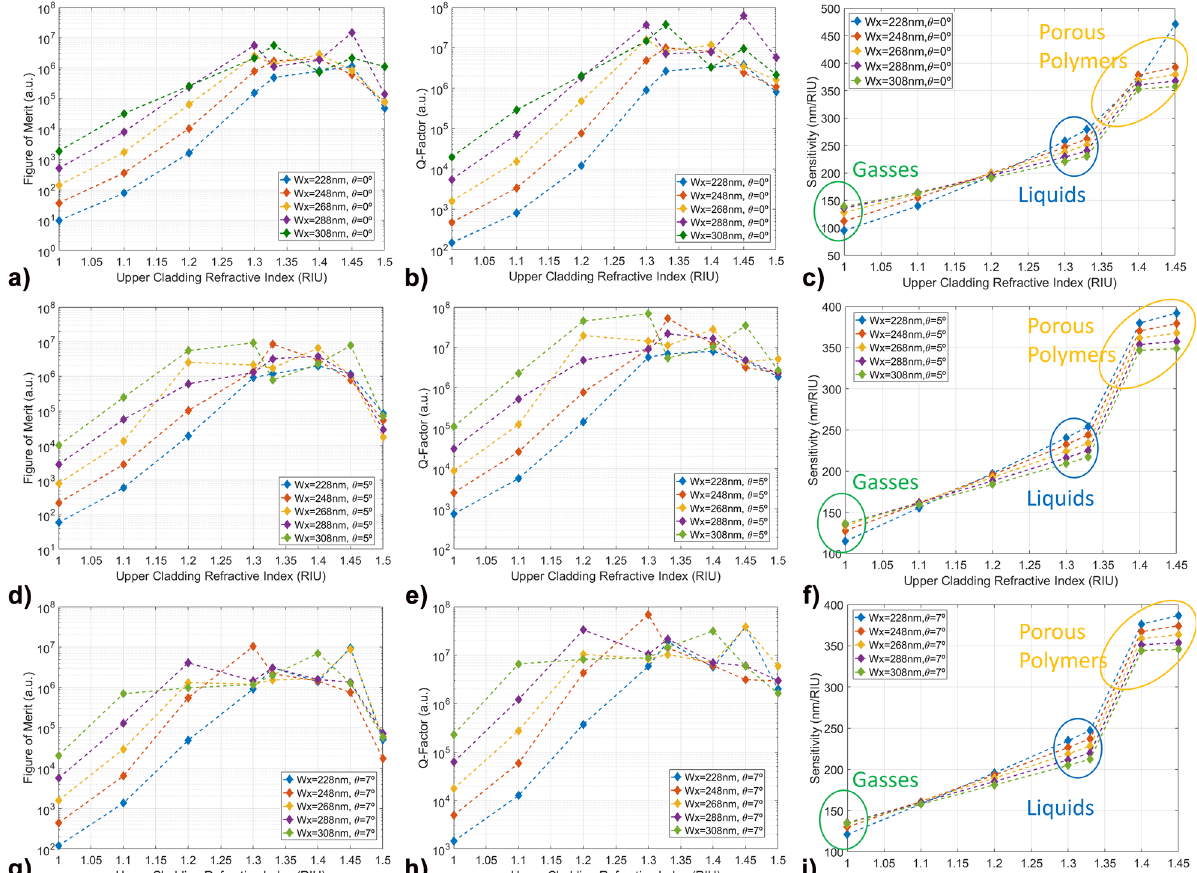
Figure 5: Simulated Figure of merit, Q-factor, and sensitivity trends with increasing upper-cladding refractive index in the different stick width and sidewall angle configurations. Each row of plots corresponds to the same sidewall angle values: (a), (b) and (c) are related to 𝜃 = 0 ◦ ; (d), (e) and (f) correspond to 𝜃 = 5 ◦ ; (g), (h) and (i) correspond to 𝜃 = 7 ◦ . In each plot, the different coloured curves are related to different sticks width ( W ). Coloured ellipses represent area of particular interest for sensing in gasses (green), liquids (blue) and common x porous polymers